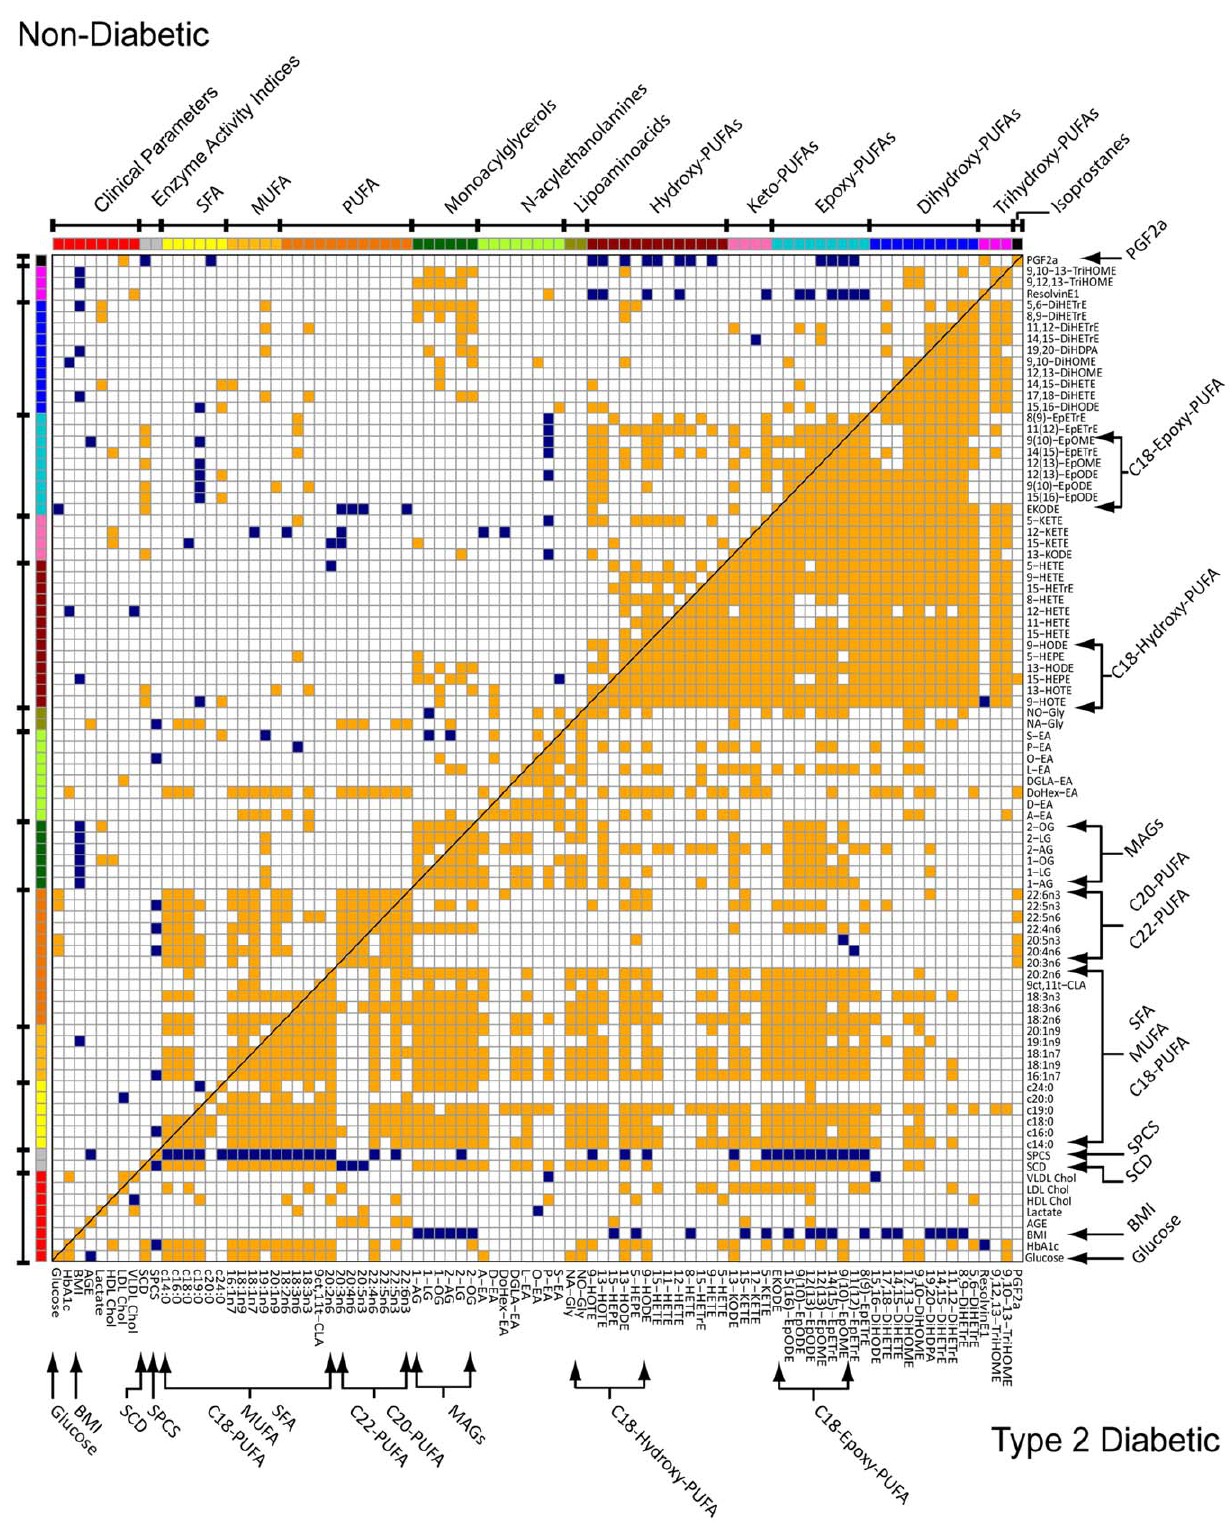
Figure 3. Analysis of correlations among all measured variables and estimated enzyme activities in non-diabetic and type 2 diabetic African-American women. Significant (p , 0.05) non-parametric Spearman’s correlations for non-diabetic (top left triangle) and type 2 diabetic (bottom right triangle) subjects are indicated by orange (positive) and blue (negative) intersections.